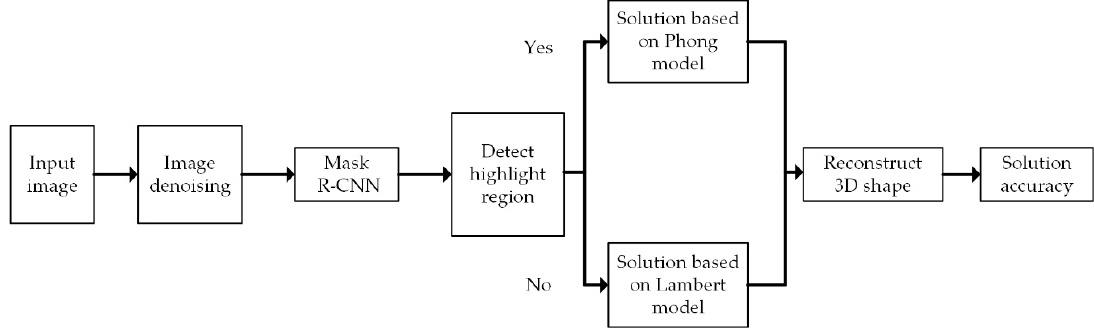
Figure 1. Algorithm flow chart.